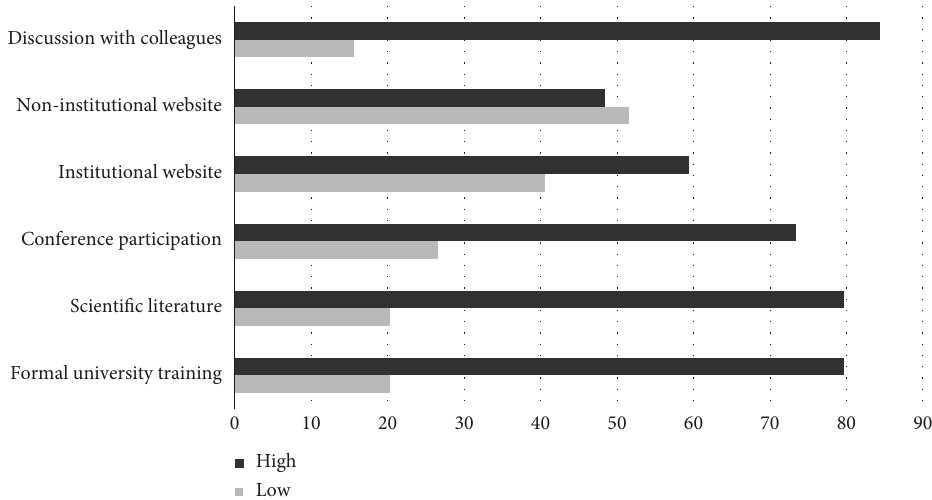
Figure 3: Self-perceived influence of different training tools in vaccine knowledge development.